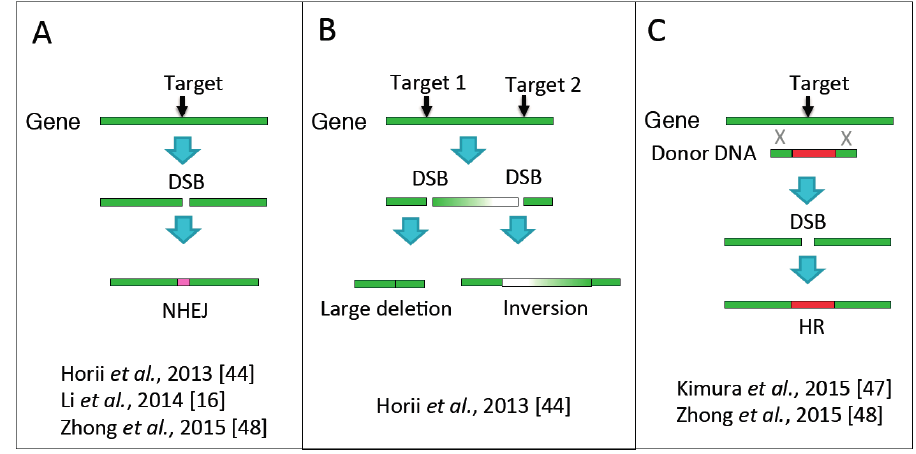
Figure 5. Genome editing in haploid ESCs using the clustered regularly interspaced short palindromic repeats (CRISPR)/Cas system. ( A ) Gene disruption by induction of double-stranded-break (DSB) formation followed by repair by non-homologous end joining (NHEJ); ( B ) deletion or inversion of large genomic regions as a result of two induced DSBs; ( C ) gene knock-in by homologous recombination (HR) with donor